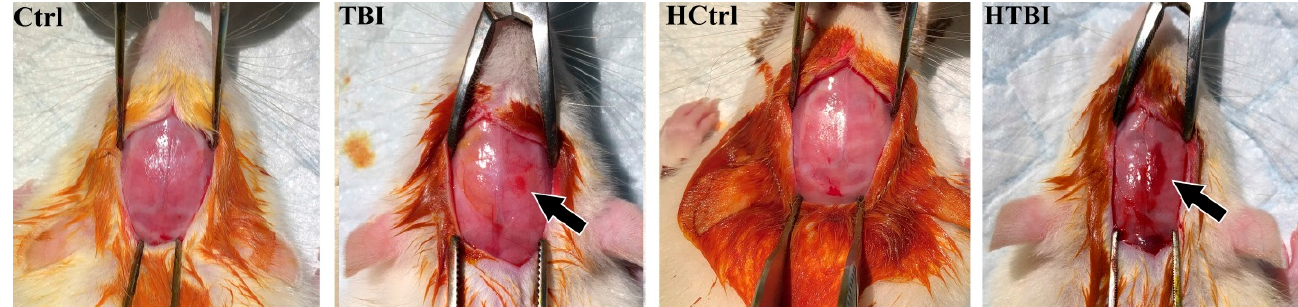
Figure 1. Post-impact hemorrhage. Shown are images of the exposed skull obtained immediately following controlled cortical impact (CCI) with black arrows pointing at the traumatic impact site in the HTBI (traumatic brain injury post- heparin) and TBI (traumatic brain injury post-saline) groups. Following our modified CCI post-heparin procedure, all rats in the HTBI group developed visibly prominent fresh blood under the skull at the impact site (arrow), without detectable ongoing gross active bleeding. Bruising with minimal hemorrhage at the impact site was seen in the TBI group. No hemorrhage was seen in controls (Ctrl) and heparinized controls (HCtrl).